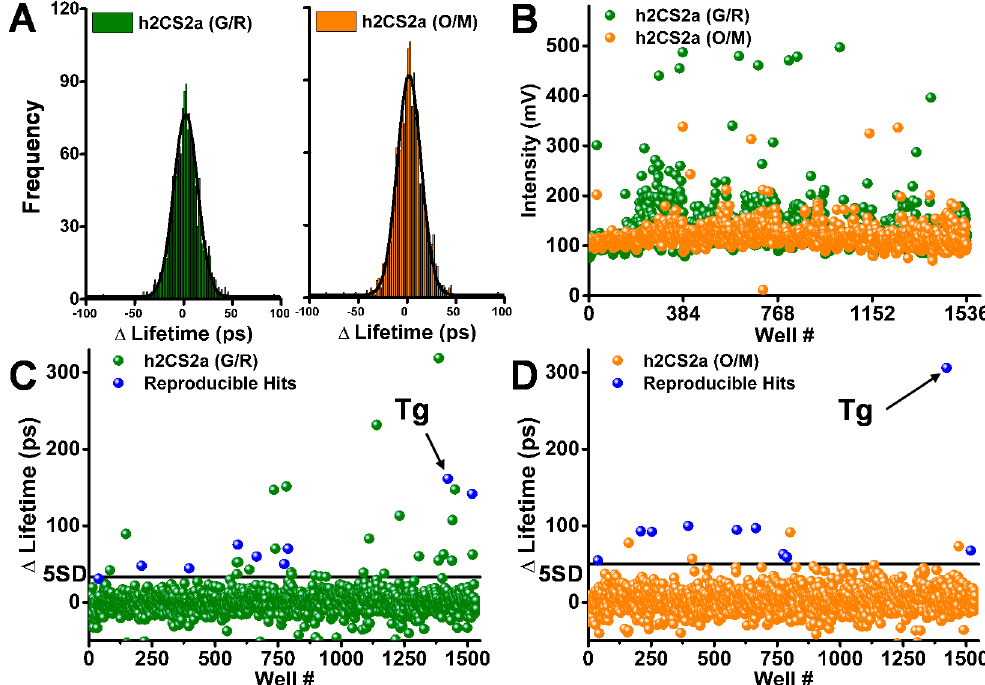
Figure 4. LOPAC library pilot screens for 2-color SERCA2a in live cells: ( A ) Histograms show distribution of observed lifetime changes from single screens, each fit to a Gaussian distribution to determine the SD (~8 ps for G/R and 11 ps for O/M). ( B ) Peak intensity (mV) for false-positive hit flagging. Bottom: lifetime change in a single 1536-well screen for G/R ( C ) and O/M ( D ). Known SERCA inhibitor thapsigargin (10 µM) shown by arrow. Reproducible hits (blue) were identified in three separate screens.